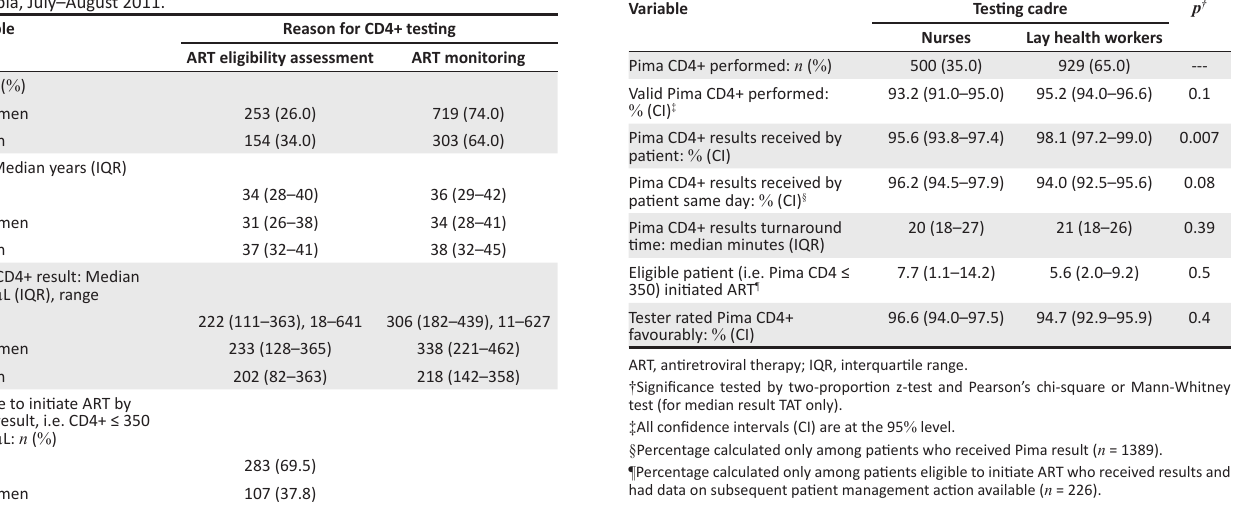
TABLE 1: Demographic and clinical characteristics of patients who received point-of-care Pima CD4+ tests performed by nurses or lay health workers, Namibia, July–August 2011.